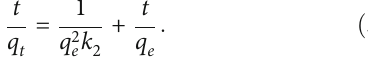
Figure 3: The e ff ect of pH on removing MB dye from solution using BC500 (room temperature, C